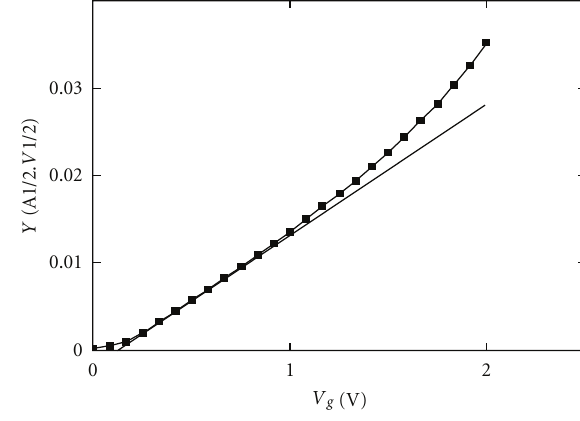
Figure 2: Characteristic Y versus gate voltage. Table 1: Values of the di ff erent extracted